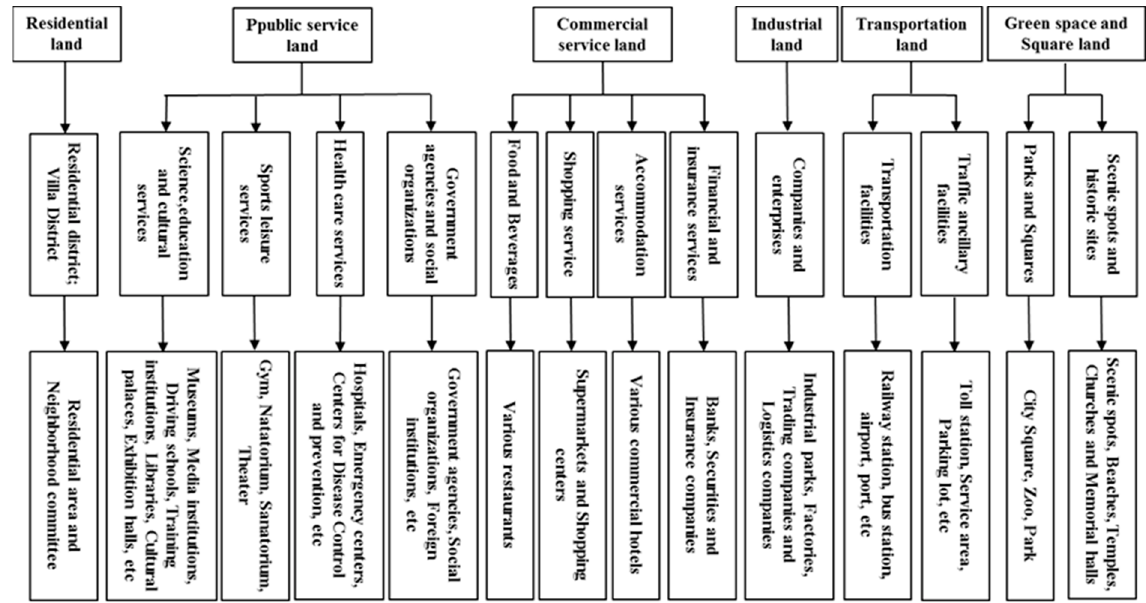
Figure 3. Reclassification of POI data (source: drawn by author).